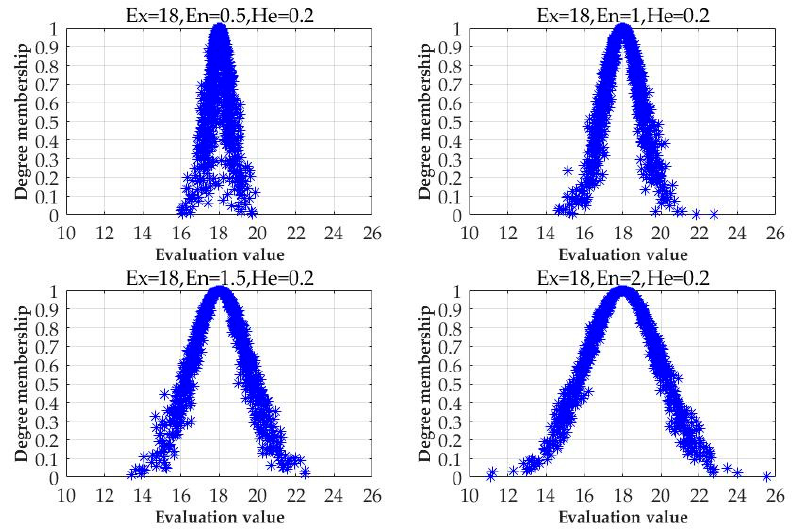
Figure 2. Effect of entropy change on cloud image.